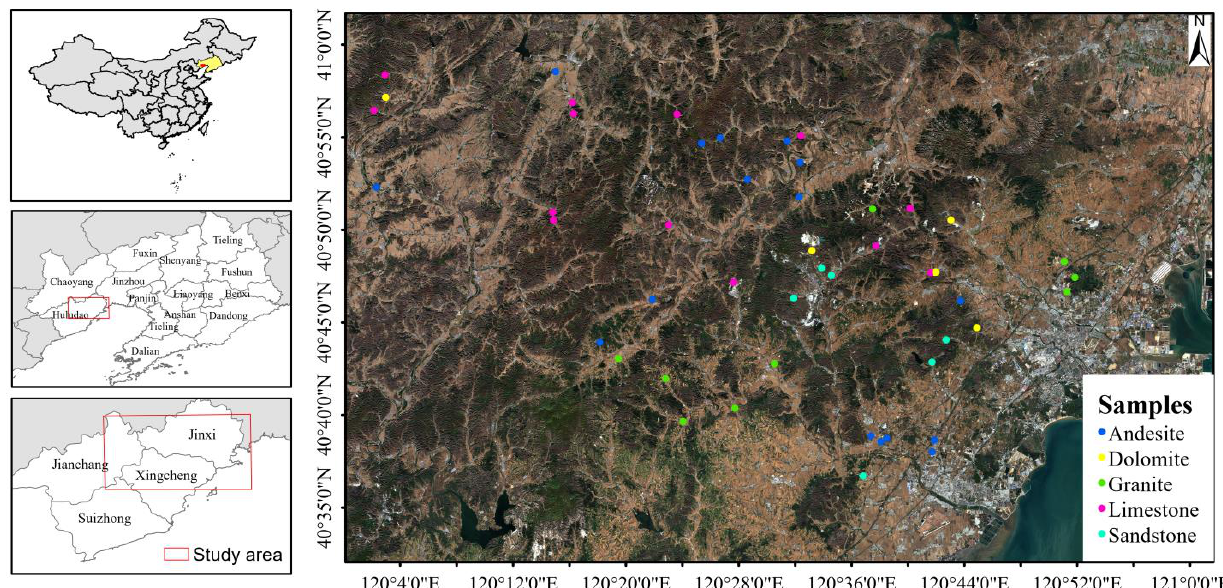
Figure 1. Distribution of samples in the study area. The background is a Sentinel-2 image collected on 18 October